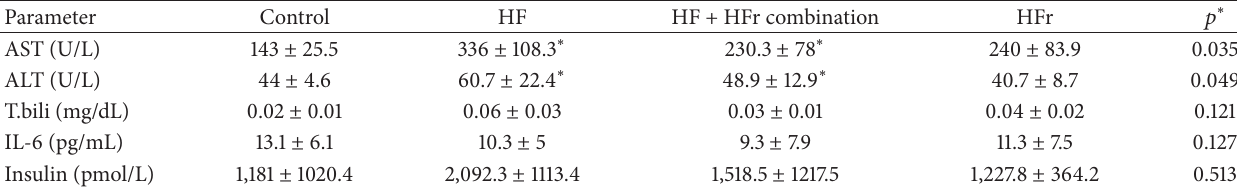
Table 1: Biochemical parameters according to nonalcoholic fatty liver disease model.